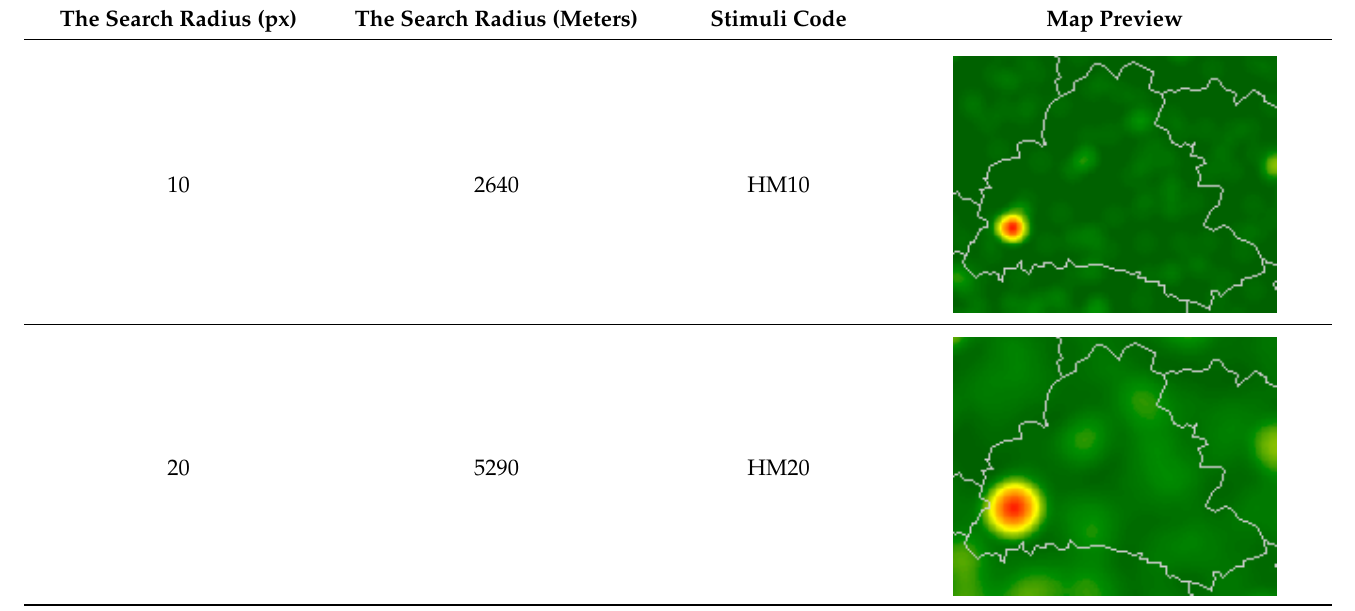
Table 1. Comparison of heat maps elaborated for the study. The Search Radius